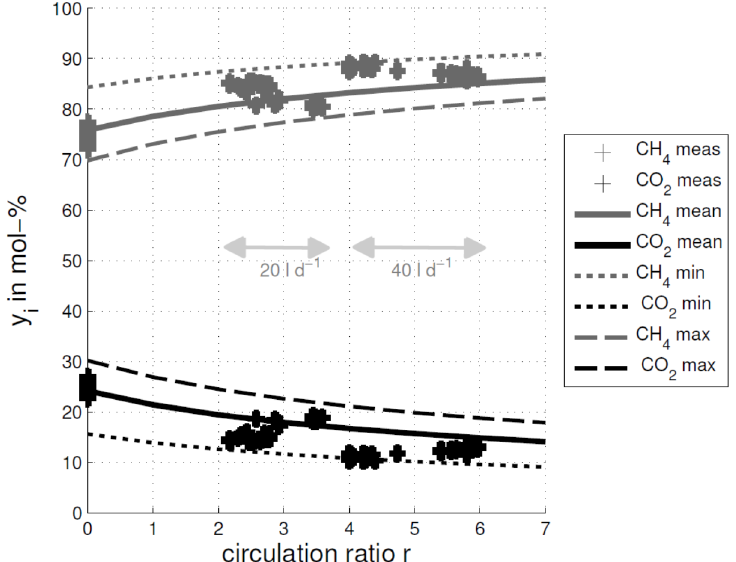
Figure 5. Gas composition of the pressurized anaerobic filter at different circulation ratios ( a ) “meas” refers to the experimental data; ( b ) “mean” refers to the calculation based on mean scenario in terms of k CH4 ; ( c ) “min” refers to the calculation based on minimum scenario in terms of k CH4 ; and ( d ) “max” refers to the calculation based on maximum scenario in terms of k CH4